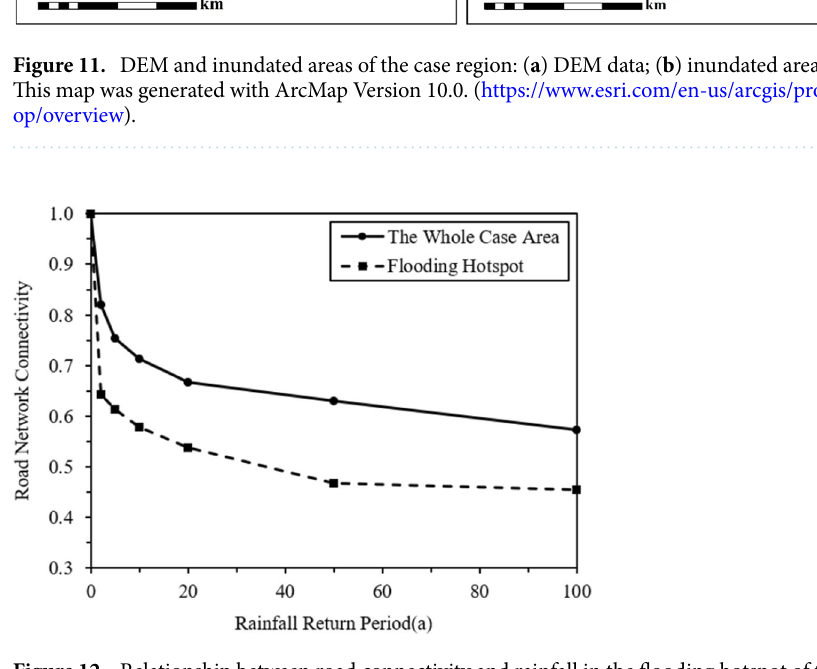
Figure 12. Relationship between road connectivity and rainfall in the flooding hotspot of the case area. This graph was generated with OriginPro 2021 (Learning Edition)(https:// www. origi nlab.